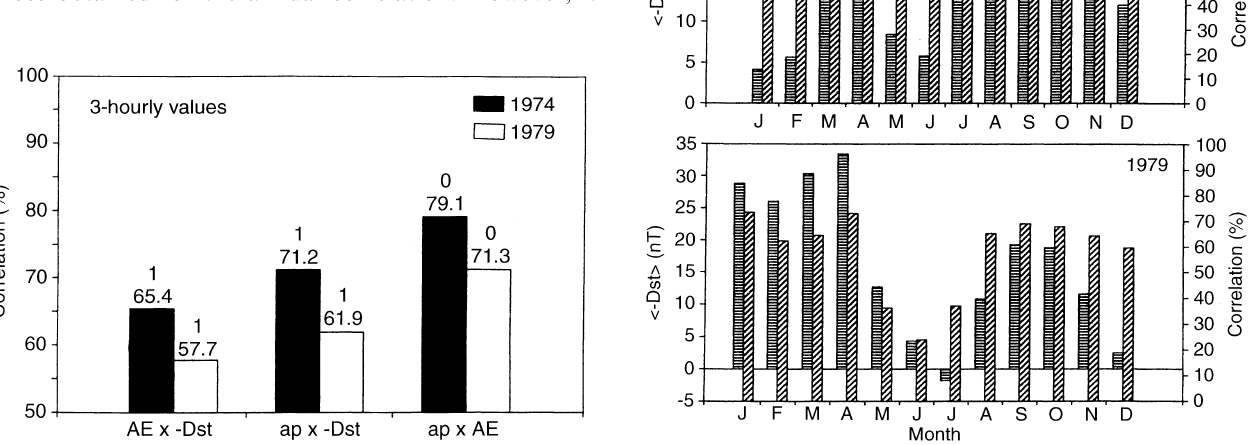
Fig. 4. Annual correlations; the lag of the best correlation for each case is shown on the top of each column